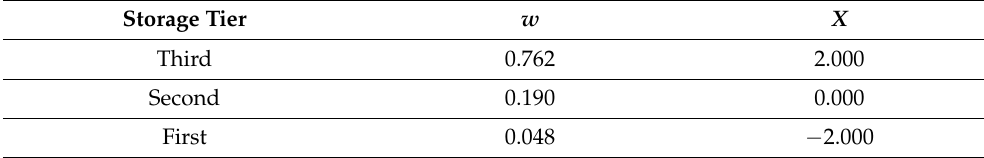
Table 11. Ranking of container storage tiers according to retention time.